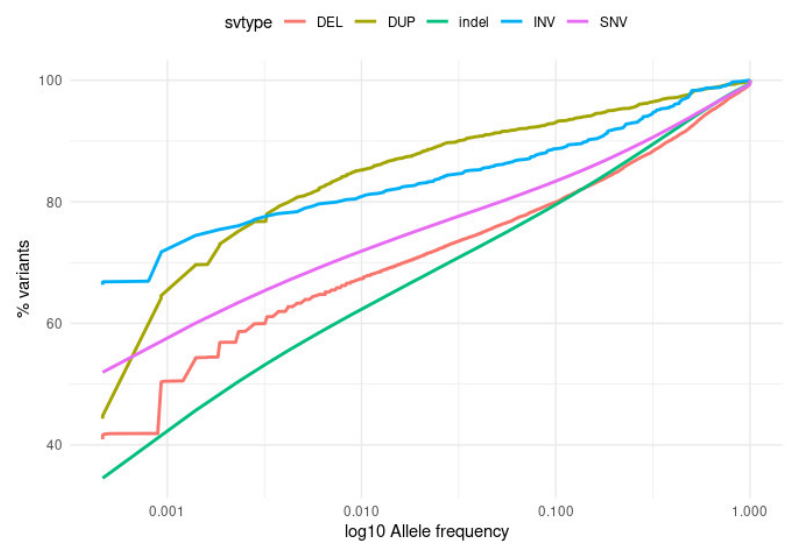
Figure 2. Distribution of allele frequencies across different variant types. DEL—large deletions; DUP—duplications; indel—short insertions and deletions; INV—inversions; SNV—substitutions. Variant impact categories follow VEP classification: HIGH—disruptive impact on the protein; MODERATE—non-disruptive variant that might change protein effectiveness; LOW—harmless or unlikely to change protein behaviour; MODIFIER—non-coding sequence variant. Table 1. Summary of variant counts in three allele frequency tiers (>0.5%; 0.1–0.5%; <0.1%). Variant impact categories follow VEP classification: HIGH—disruptive impact on the protein; MODER- ATE—non-disruptive variant that might change protein effectiveness; LOW—harmless or unlikely to change protein behaviour; MODIFIER—noncoding sequence variant.